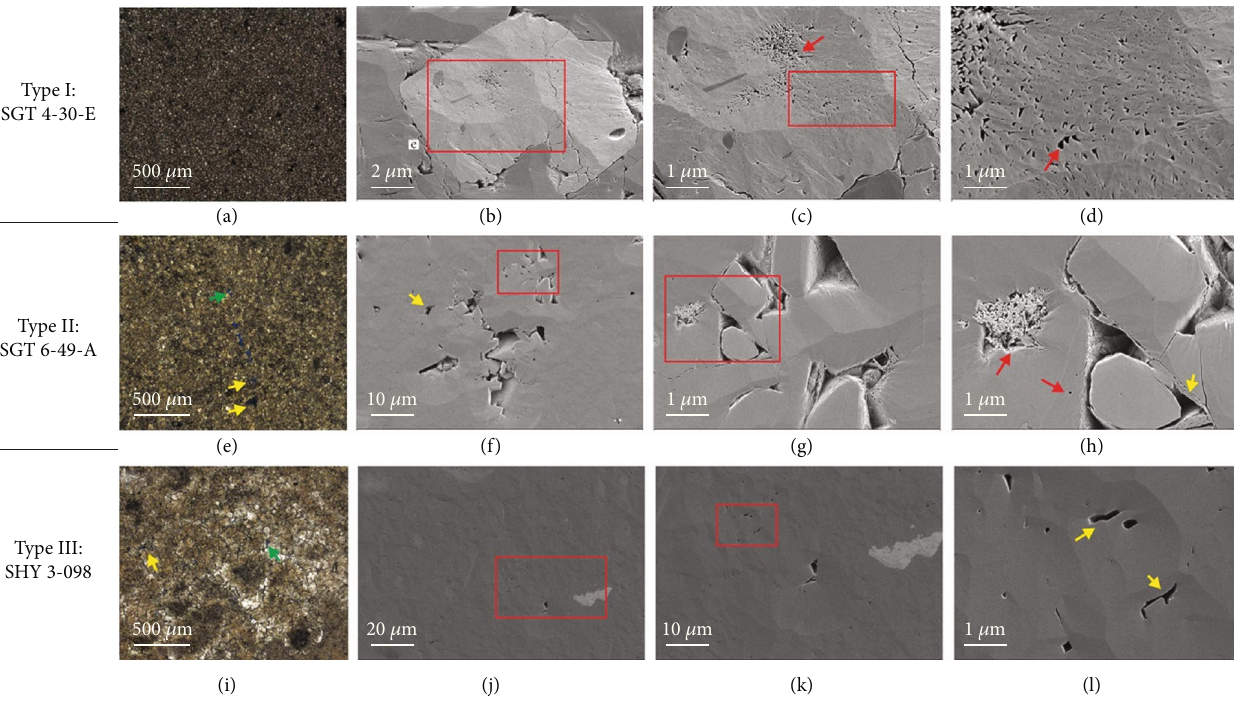
Figure 9: Photomicrographs of typical samples from Type I, Type II, and Type III ((a), (e), and (i) obtained from optical microscopy; the others from FE-SEM); red arrows: intragranular (dissolution) pores; green arrows: intercrystalline pores; yellow arrows: intergranular